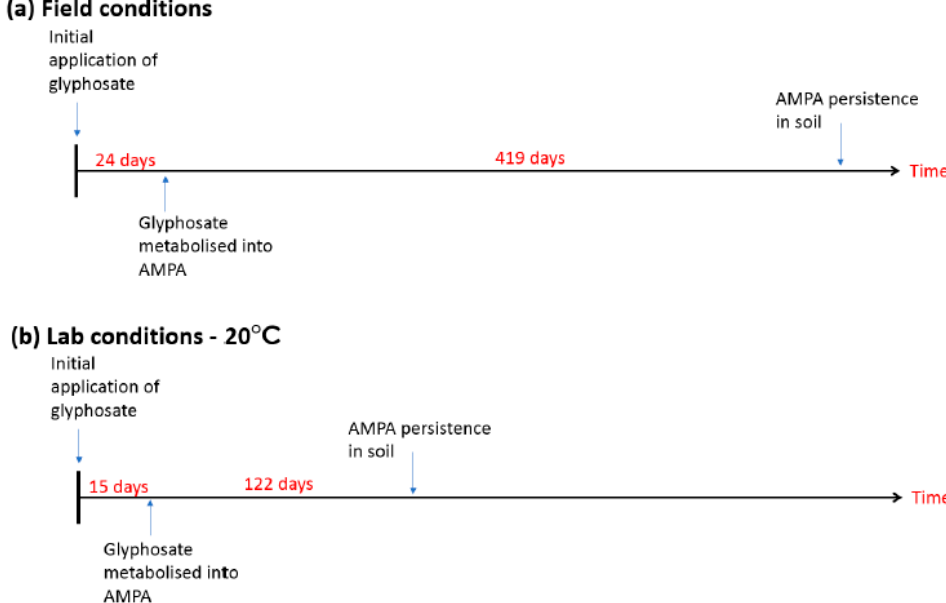
Figure 1. Timeline of glyphosate metabolism and Aminomethylphosphonic acid (AMPA) persistence in soils from both field soils ( a ) and laboratory controlled soils ( b ), constructed from data provided by the Pesticide Properties DataBase (PPDB) [3].